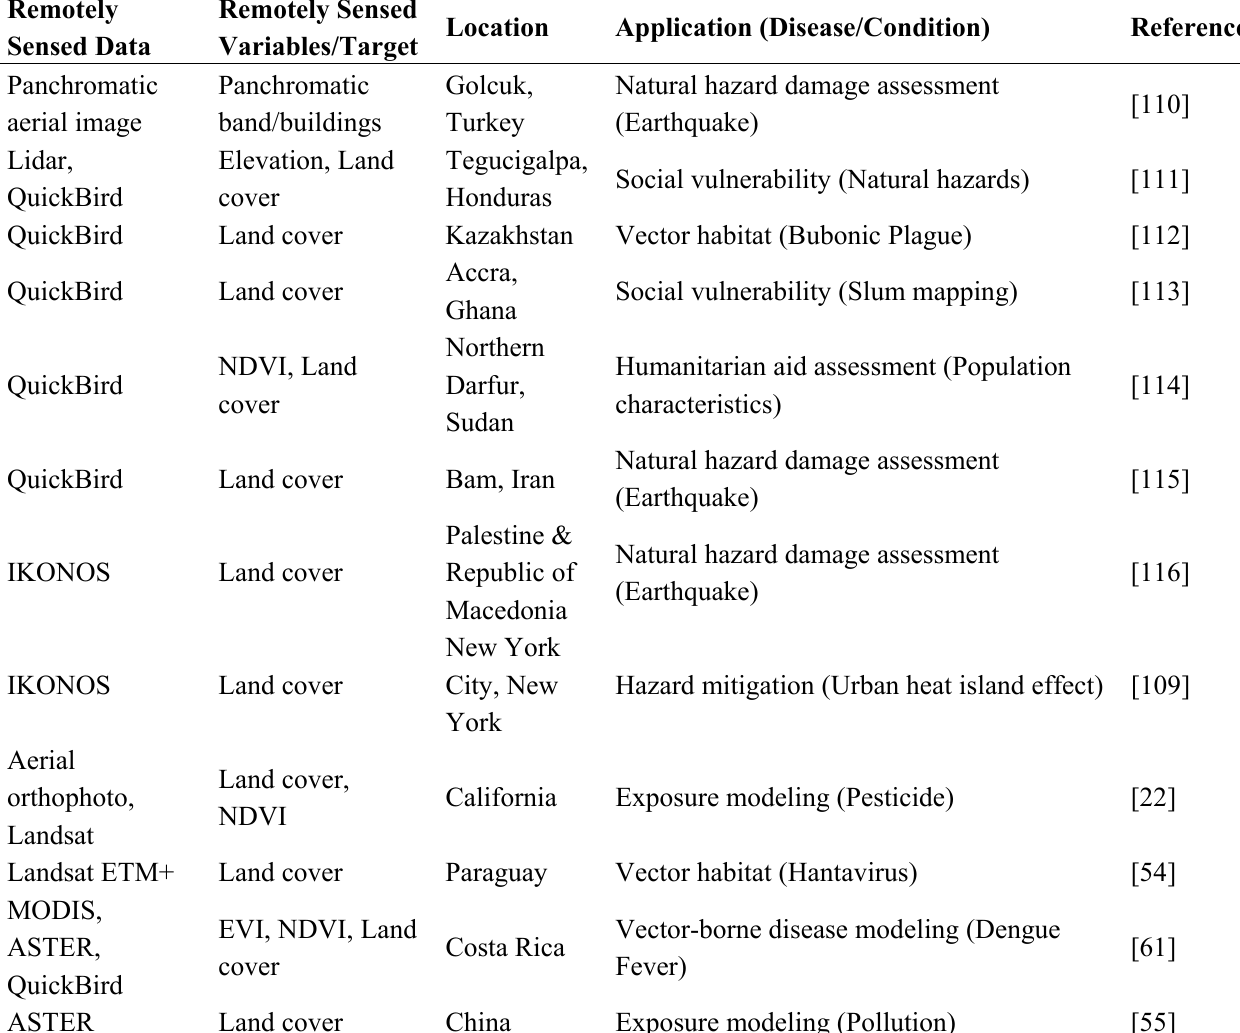
Table 3. Summary of literature in public health using object-based image